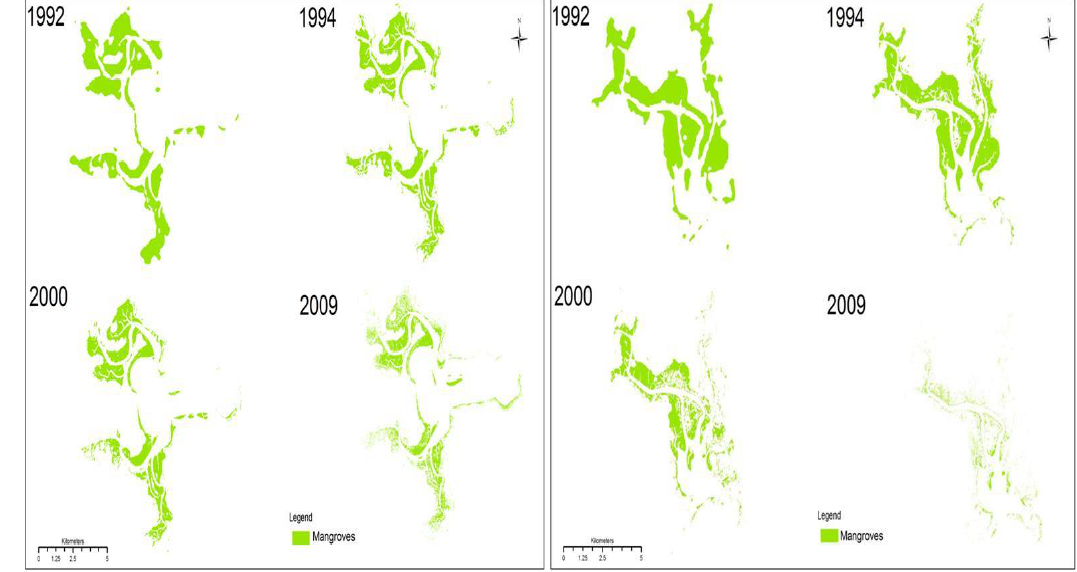
Fig. 5. Forest cover change from 1992 to 2009 in Mwache and Tudor creeks respectively.